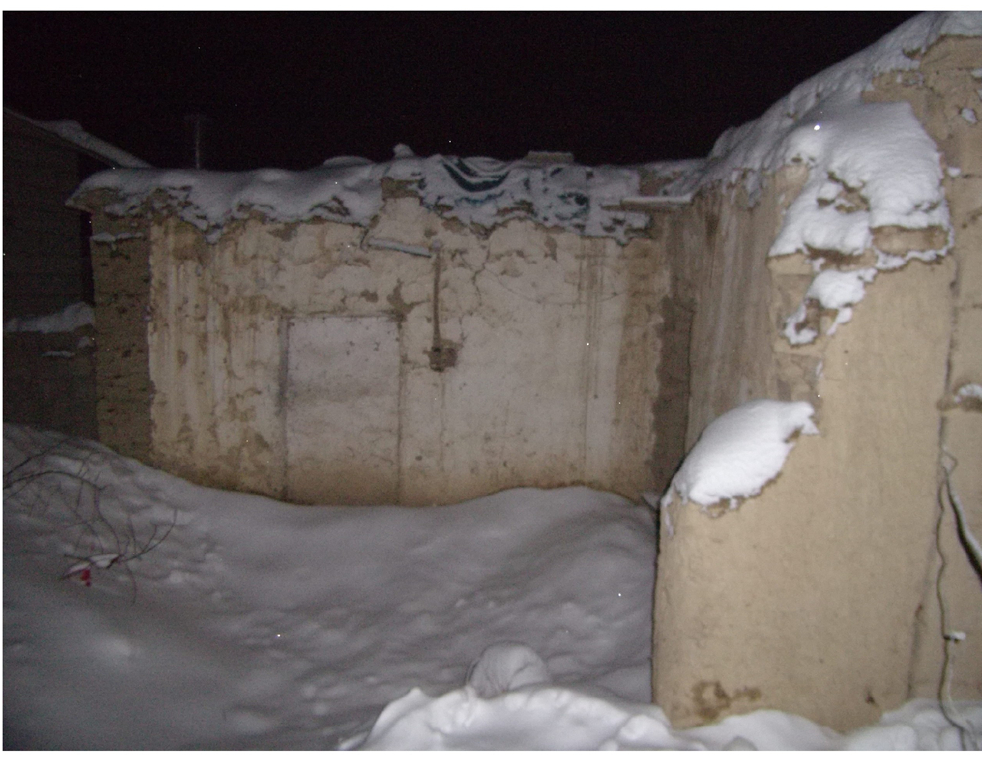
Fig. 22. A partially collapsed adobe building where the debris was